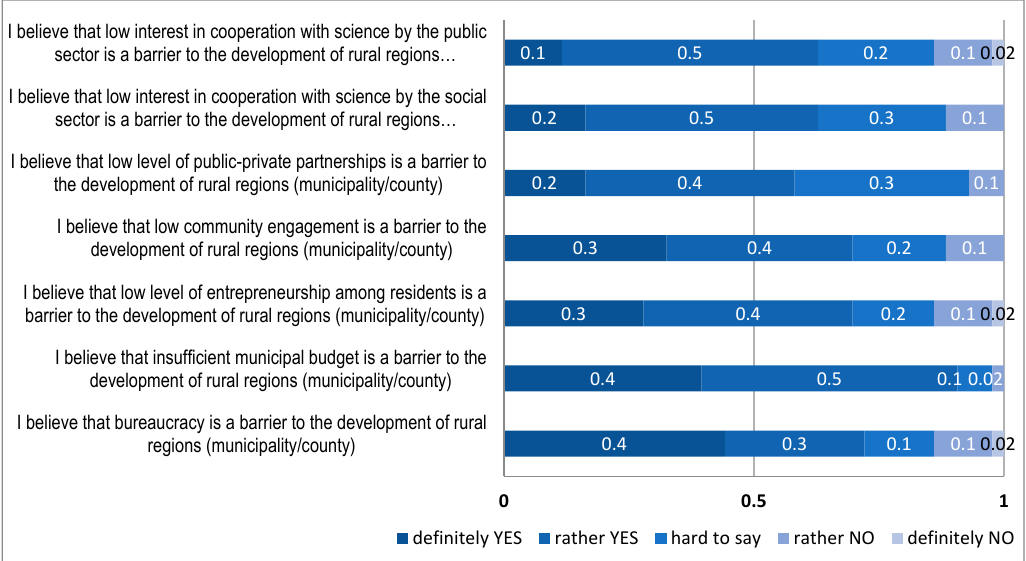
Figure 4. Barriers of rural regions development.